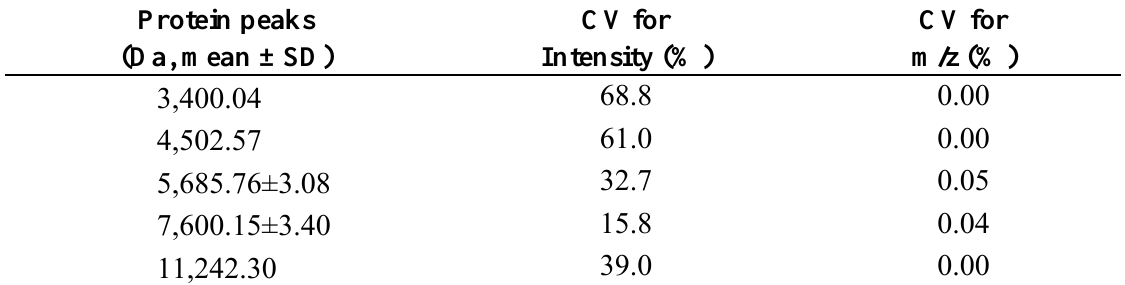
Table 7. SELDI-TOF-MS assay reproducibility of 10 times duplicate assays of one sera